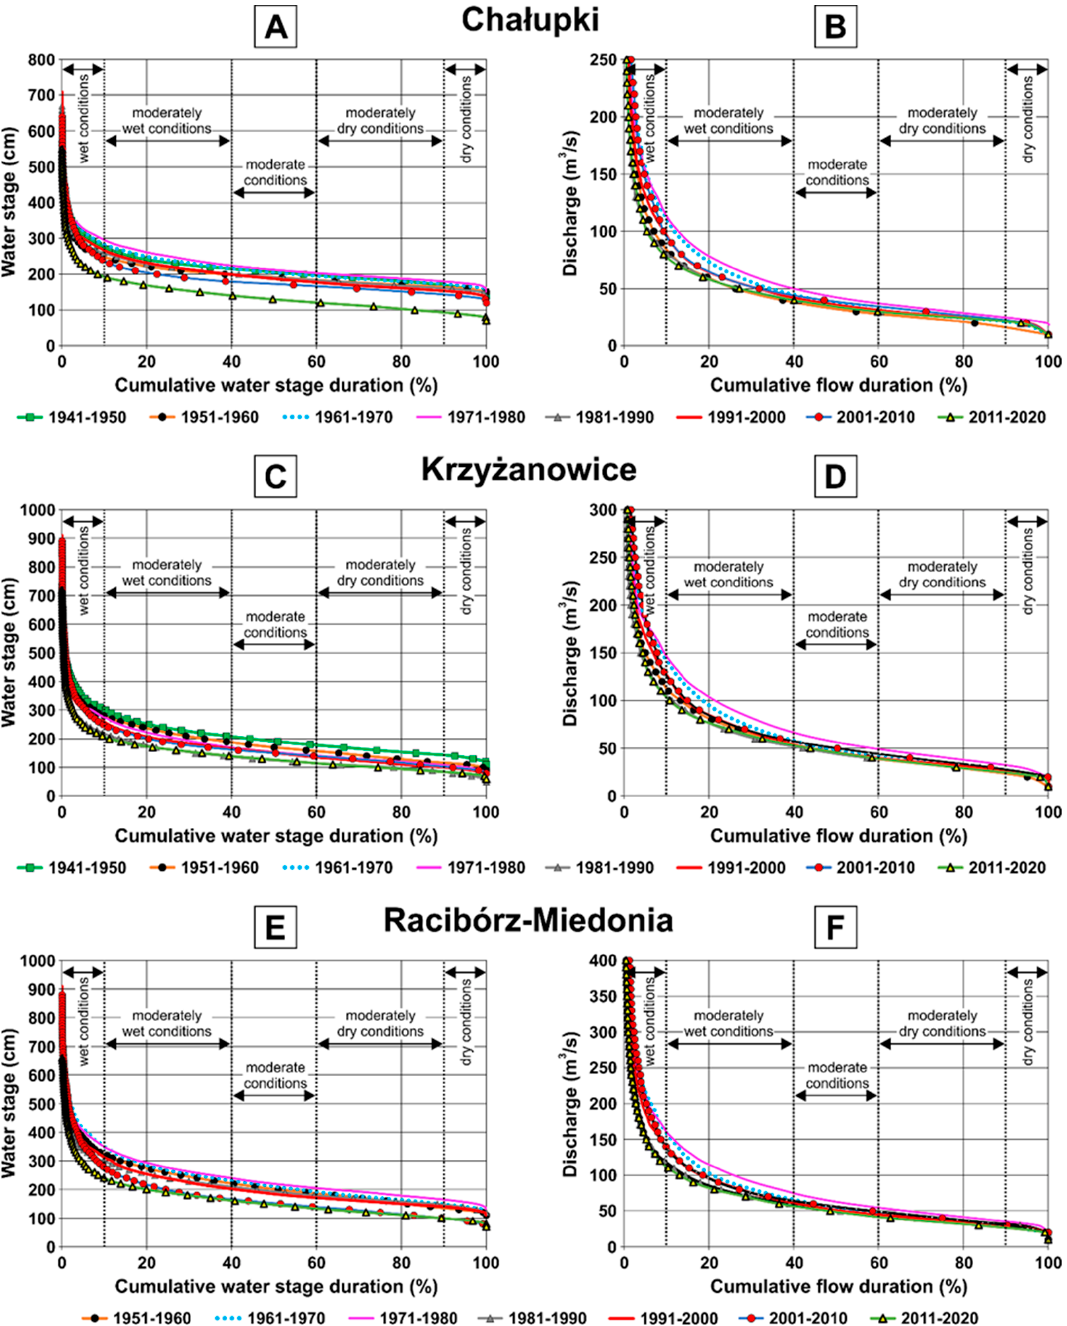
Figure 2. Water-stage ( A , C , E ) and discharge ( B , D , F ) duration curves for water-gauge stations from Section 1 of the Odra River. Note that the DD curves do not comprise the highest discharges (maximum discharges recorded at the Cha ł upki, Krzy ż anowice, and Racibórz–Miedonia stations were 1820, 2620, and 2800 m 3 s − 1 , respectively), and thus discharges in the right panels do not correspond to water stages in the left panels. At the Cha ł upki station, the oldest DD curve is available for the years 1951–1960 and at Krzy ż anowice for the years 1956–1960.